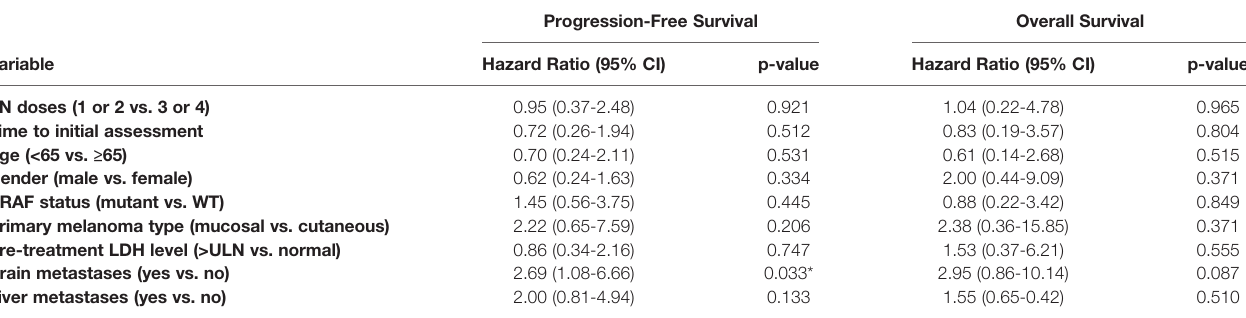
TABLE 5 | Multivariable Cox regression of progression-free survival and overall survival on the number of I/N (ipilimumab/nivolumab) doses and prognostic variables among patients who had clinical bene fi t response after 1 or 2 doses of I/N. n = 94. Progression-Free Survival Overall